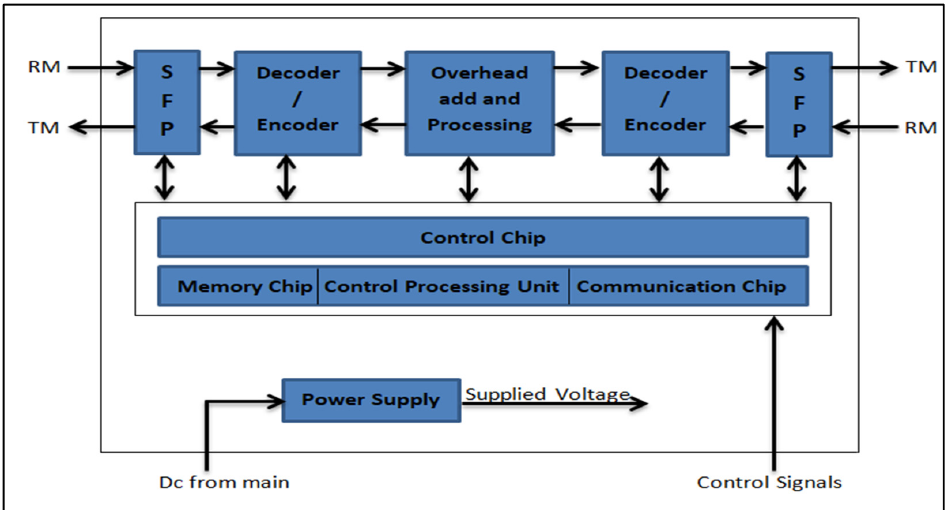
Figure 5. The OSC board block diagram before integrating the FPMT detection circuit.